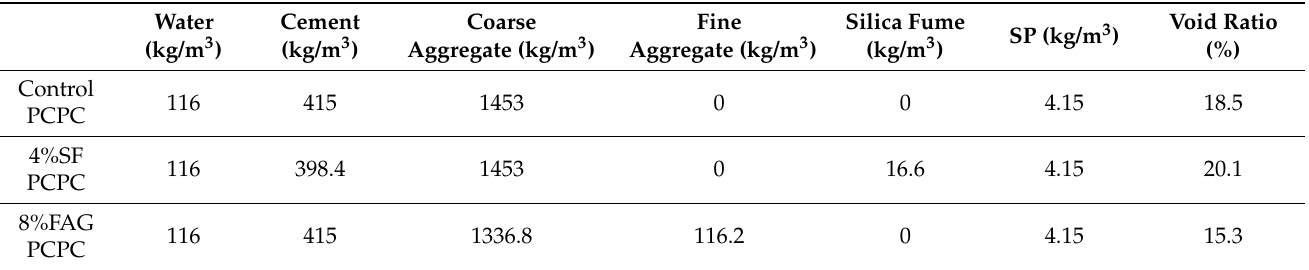
Table 2. Mixing proportions and void ratio of